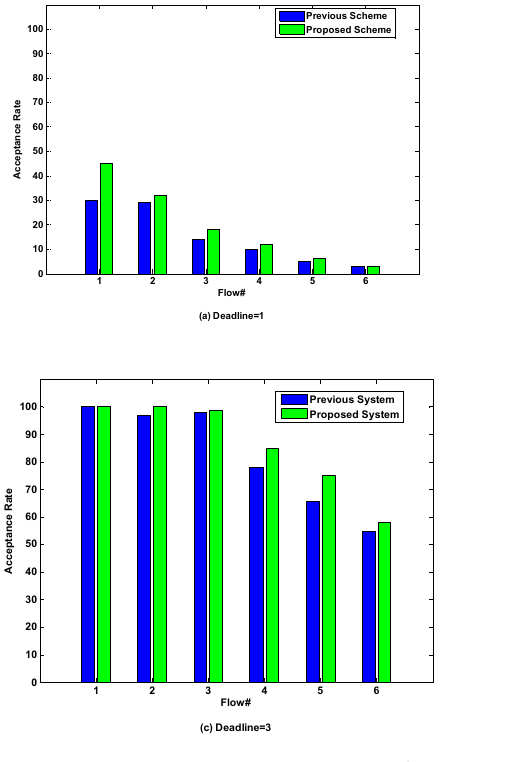
Figure 4. Simulation results for w.r.t